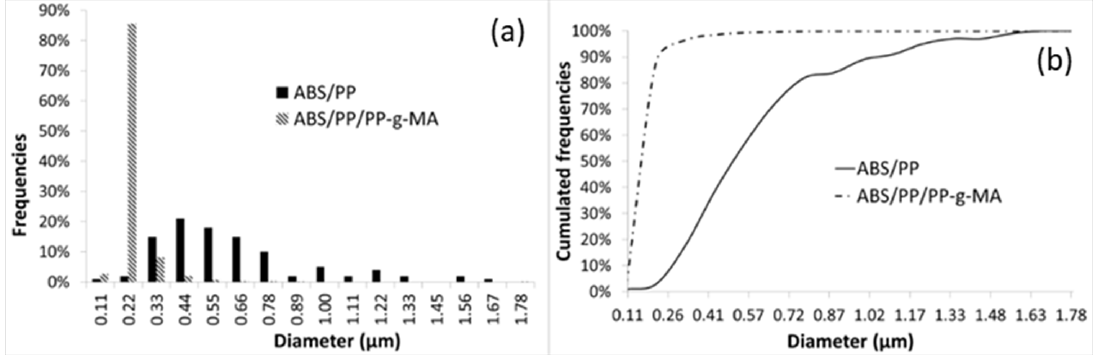
Figure 10. Frequencies ( a ) and cumulated frequencies ( b ) of diameters sizes distribution for ABS/PP and ABS/PP/PP-g-MA composites.